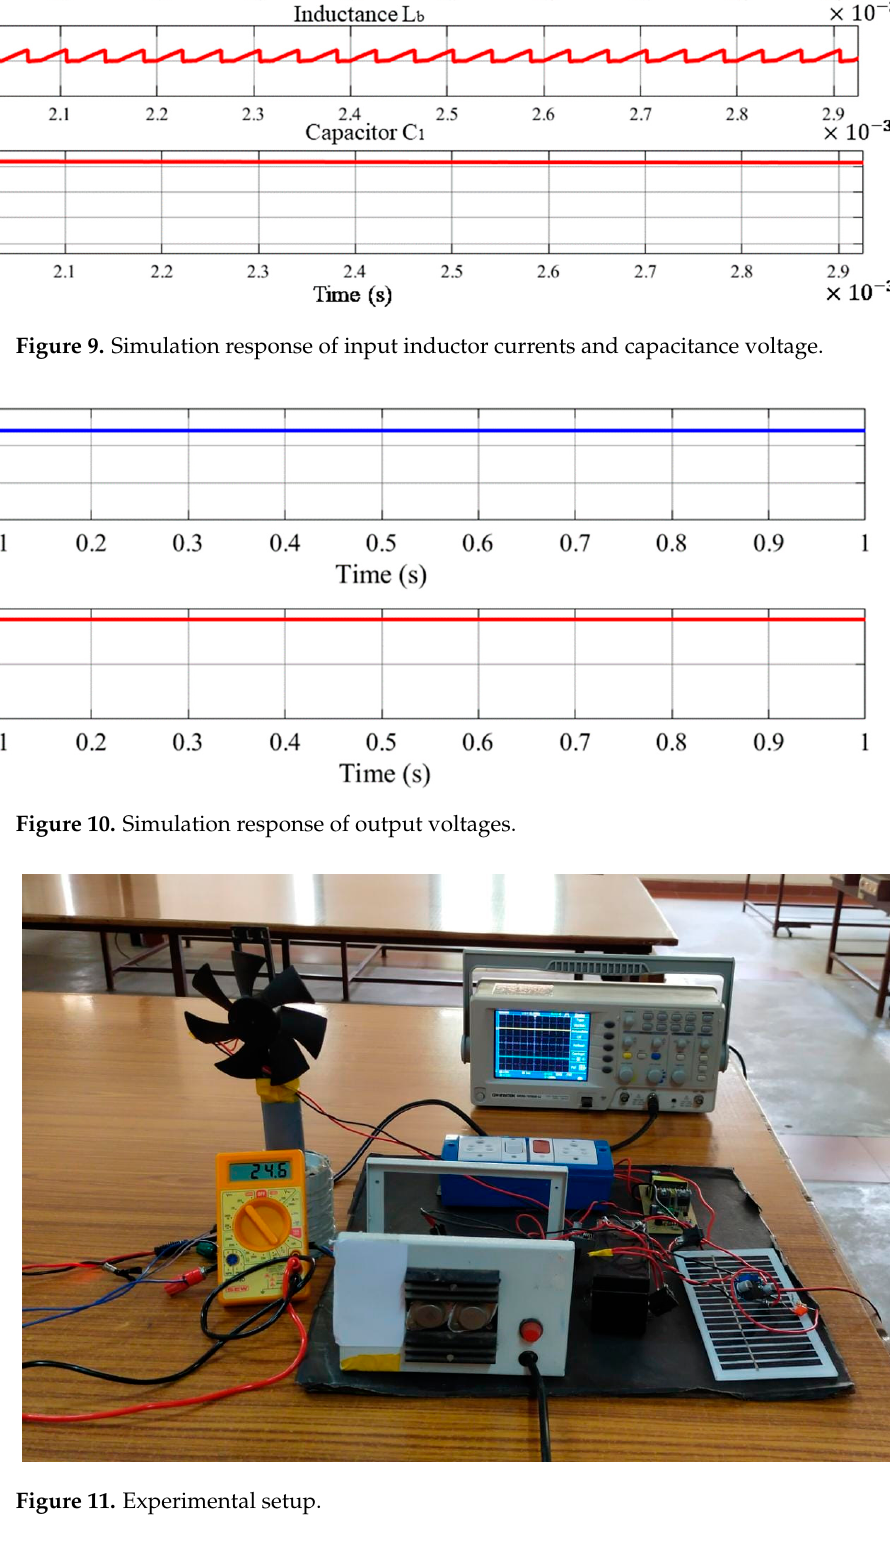
Figure 11. Experimental setup.